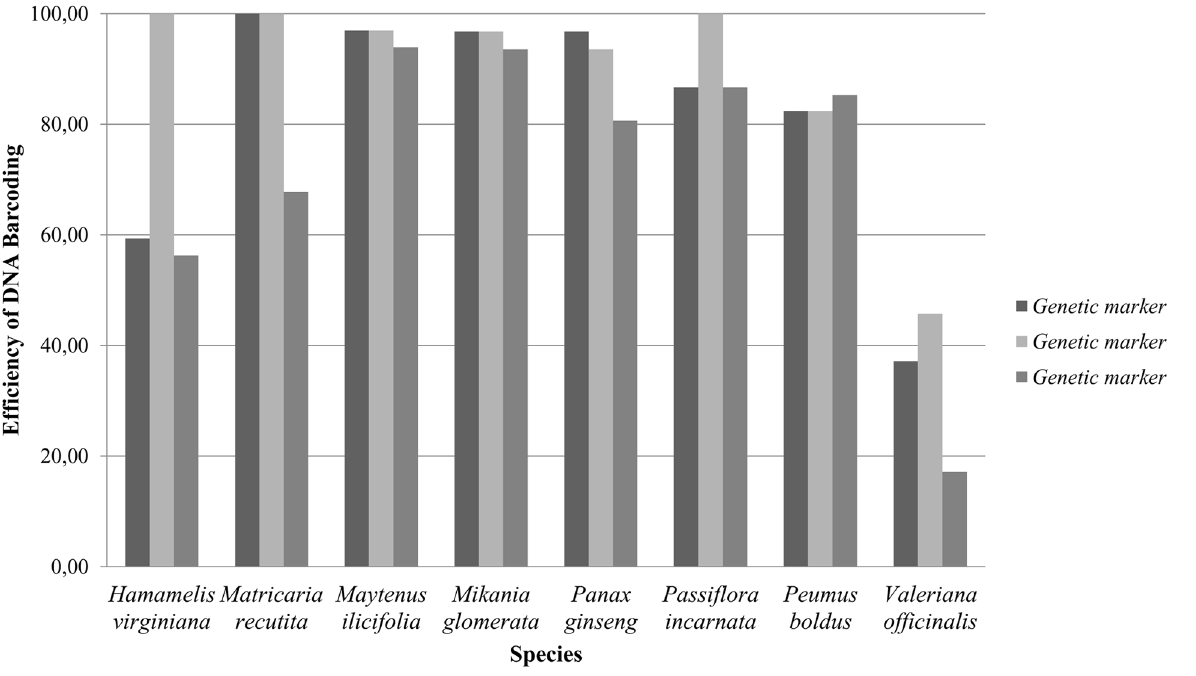
Fig 1. Percentage of samples analyzed according to species and genetic